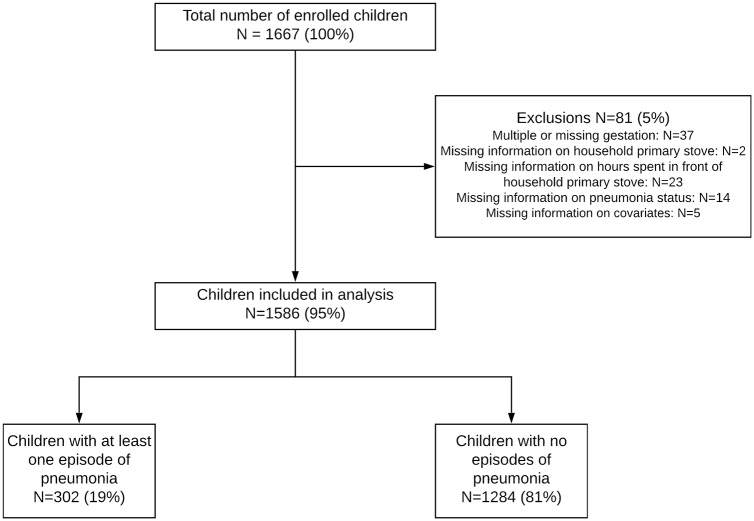
Study population flow diagram.